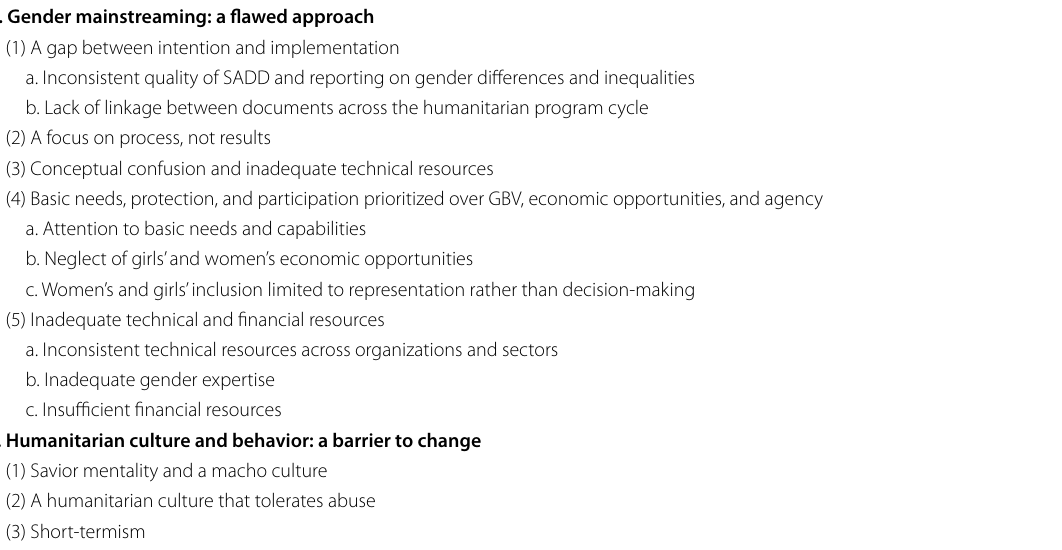
Table 2 Summary of key